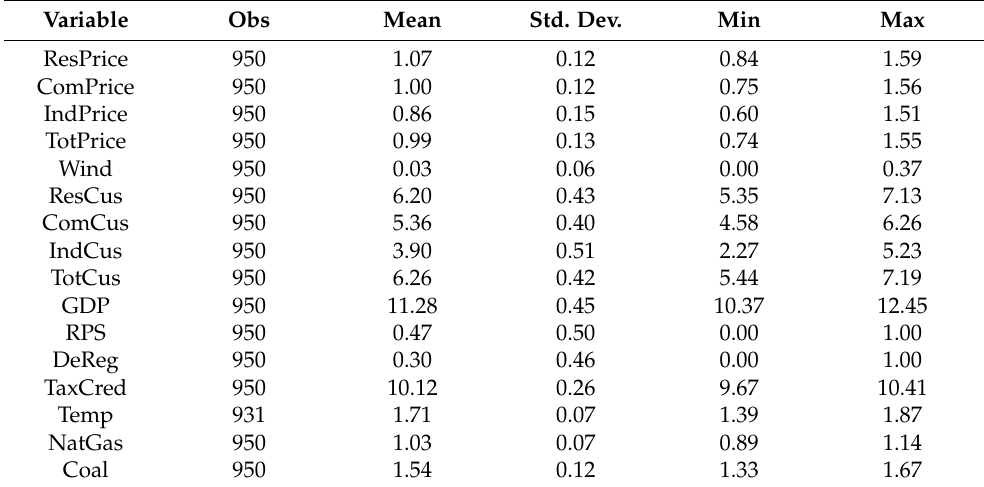
Table 1. Data descriptive